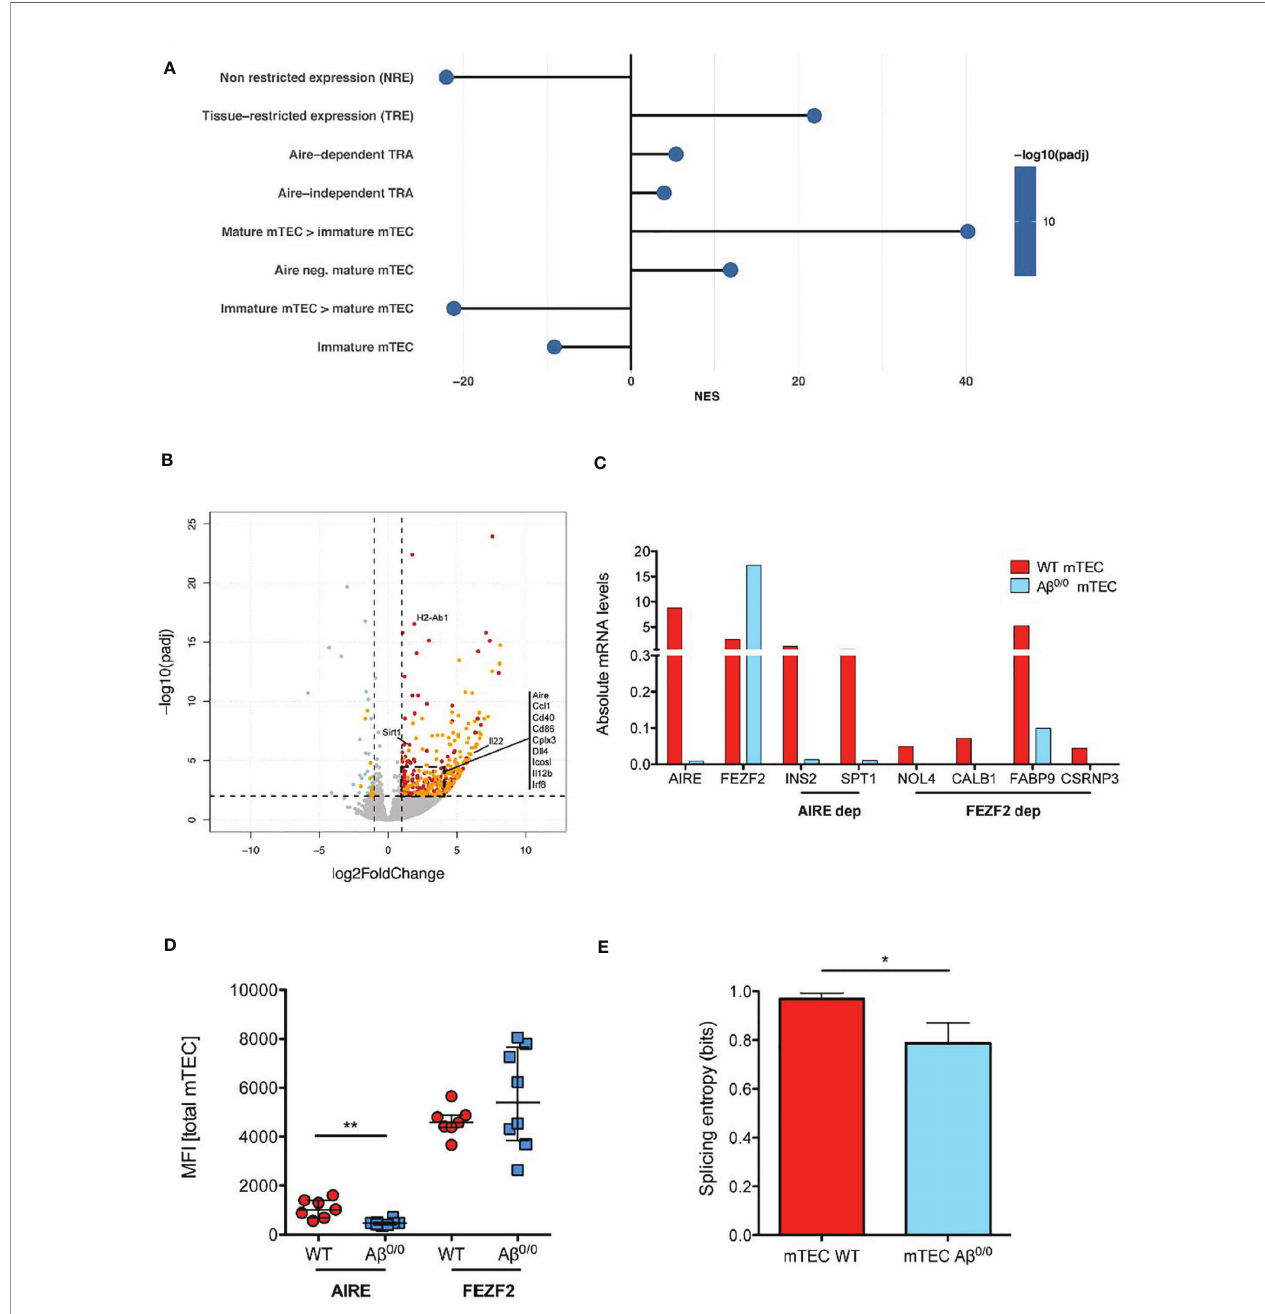
FIGURE 5 | TEC transcriptome perturbation in the absence of MHC class II. (A) Enrichment Analysis of Gene Sets involved in promiscuous gene expression and maturation in mTEC. The normalized enrichment score (NES) is reported for each gene set. Positive NES indicate gene sets enriched in WT mTEC, negative NES indicate gene sets enriched in A b 0/0 mTEC. This analysis was performed based on gene lists published in (33). (B) Volcano plot representing results of differential gene expression (DE) analysis of genes between WT and A b 0/0 mTEC. In red are represented genes more expressed in WT mTEC, in light blue those more expressed in A b 0/0 mTEC. In orange are evidenced genes with tissue-restricted expression (TRE). (C) Absolute mRNA level of Aire, Fefz2, and some TRA (Aire- or Fezf2-dependent), quanti fi ed by RT-PCR performed on sorted WT or A b 0/0 mTEC, pooled from 2 – 3 sorting experiments. Ins2, insulin; Spt1, serine palmitoyltransferase; Nol4, nucleolar protein 4 (testis); Calb1, calbindin (brain, kidney), Fabp9, fatty acid binding protein 9 (testis); Csrnp3, cysteine-serine-rich nuclear protein 3. (D) AIRE protein expression is reduced in mTEC lacking MCHII. Graph shows the mean fl uorescence intensity (MFI) of AIRE and FEZF2 proteins by fl ow cytometry in total mTECs after intracellular staining in WT (n = 7) or A b 0/0 (n = 8) mTEC, respectively. **p-value < 0.01. (E) Splicing entropy, a measure of the diversity of observed transcripts isoforms in a given sample, resulted decreased in A b 0/0 mTEC. The analysis was restricted to TRA only. The formula used for the calculation of mRNA splicing entropy was derived from (31). Results are expressed as mean and standard deviation. *p value <